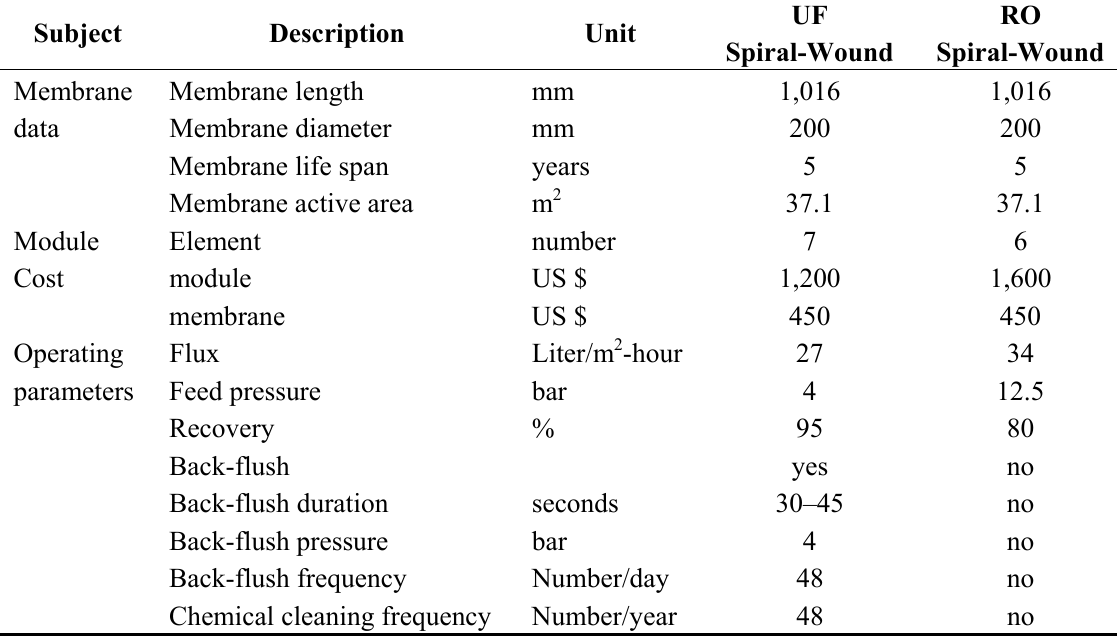
Table 5. Selected design and operating parameters for membrane plant cost